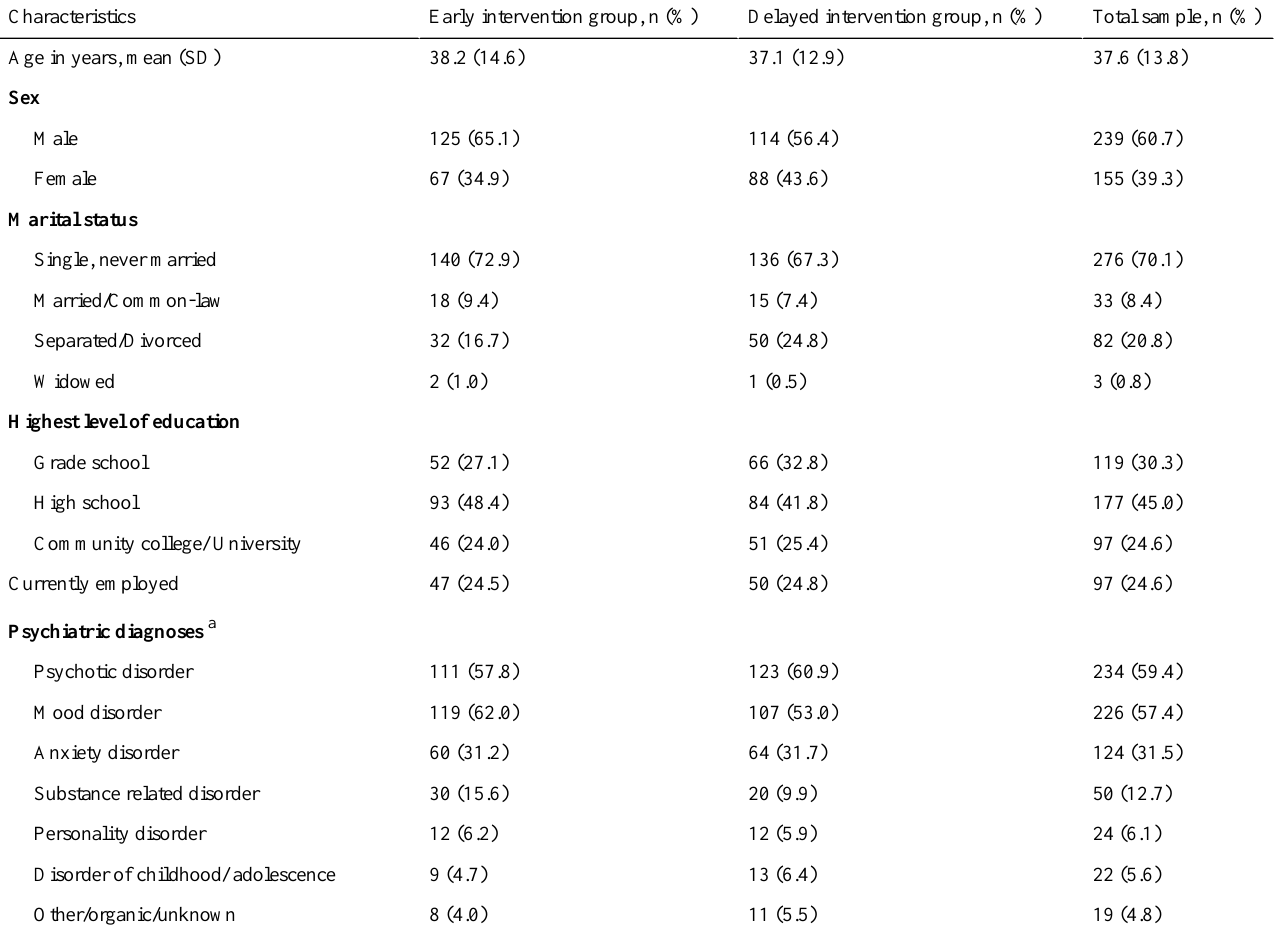
Table 1. Sample characteristics (N=394) of MHEN study